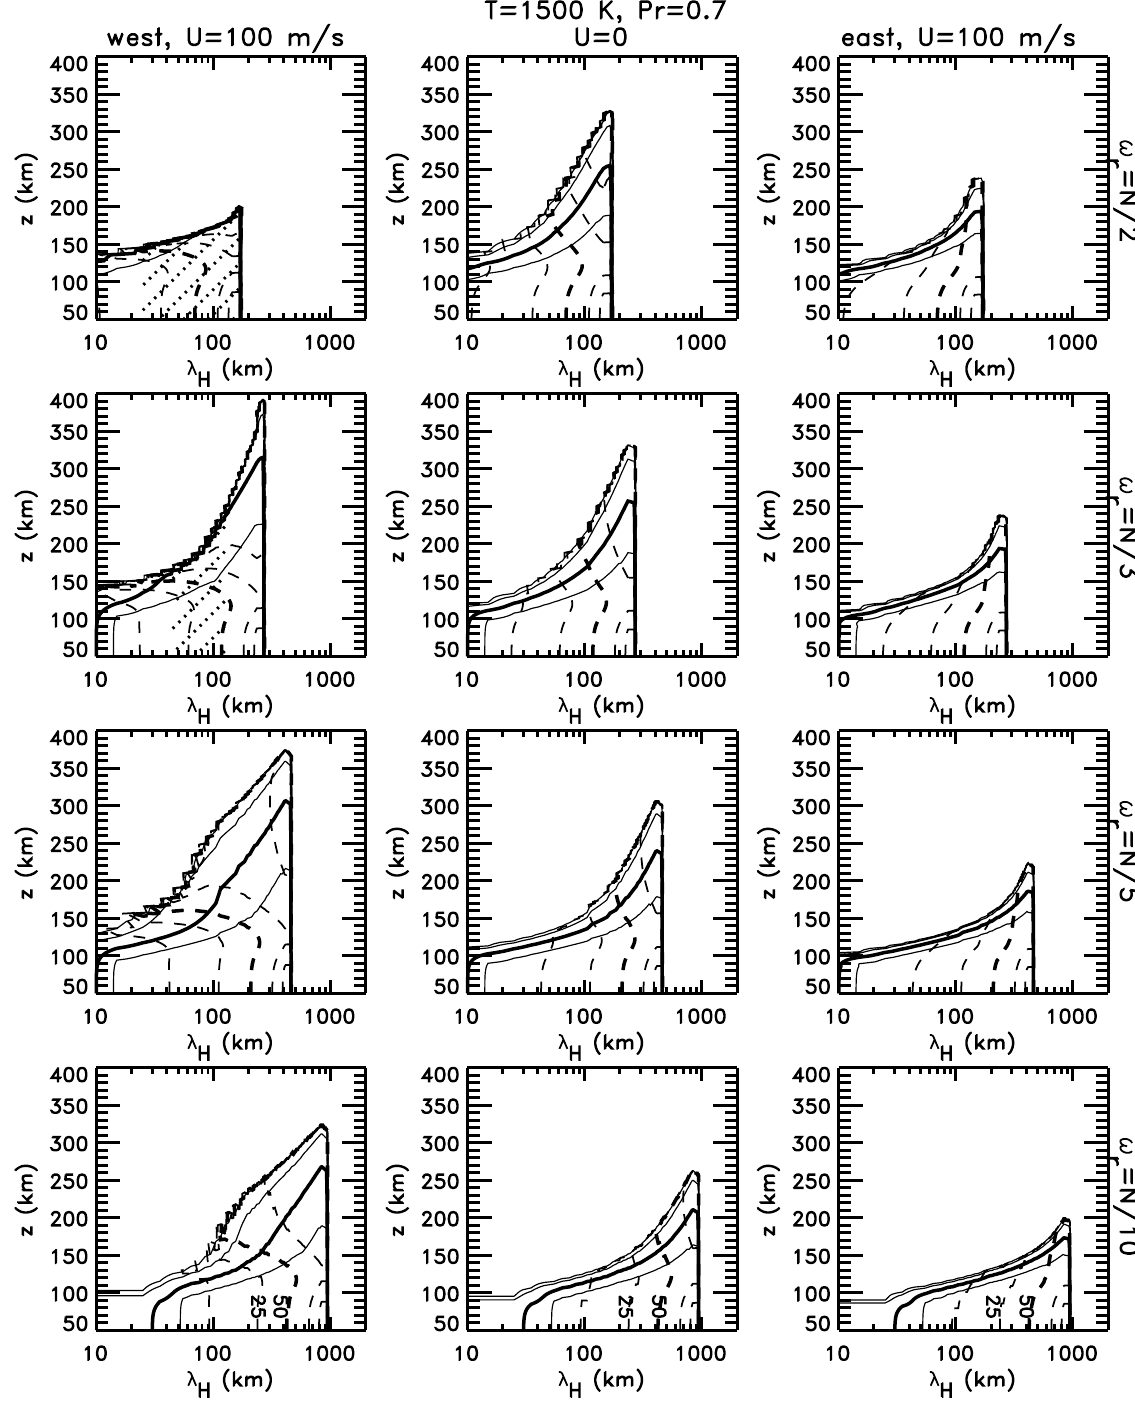
Fig. 4. As in Fig. 2, but for maximum solar forcing and thermospheric temperatures ( ∼ 1500K).